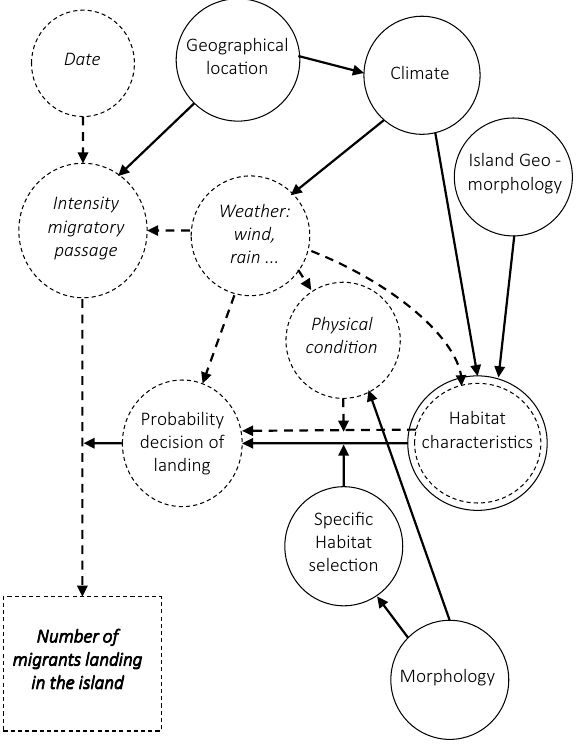
Figure 1. Conceptual model of the factors affecting the number of migrants of a species that make stopovers on an island. Continuous line circles and arrows identify factors that are constant over the long term. Dashed line circles and arrows identify factors that are highly variable, and change from day to day. Habitat characteristics are intermediate because some habitat components are stable (e.g. dominant vegetation types) while others may change through the migration season or between seasons (e.g. abundance of fruits or insects). Arrows ending over other arrows represent the modulating effect of some variables on the relationship of habitat characteristics and the landing decision. The interaction of the daily intensity of migratory passage and the probability of the decision to land of individual birds should determine the number of migrants actually landing each day. The sum of these numbers yields the number of migrants in a given